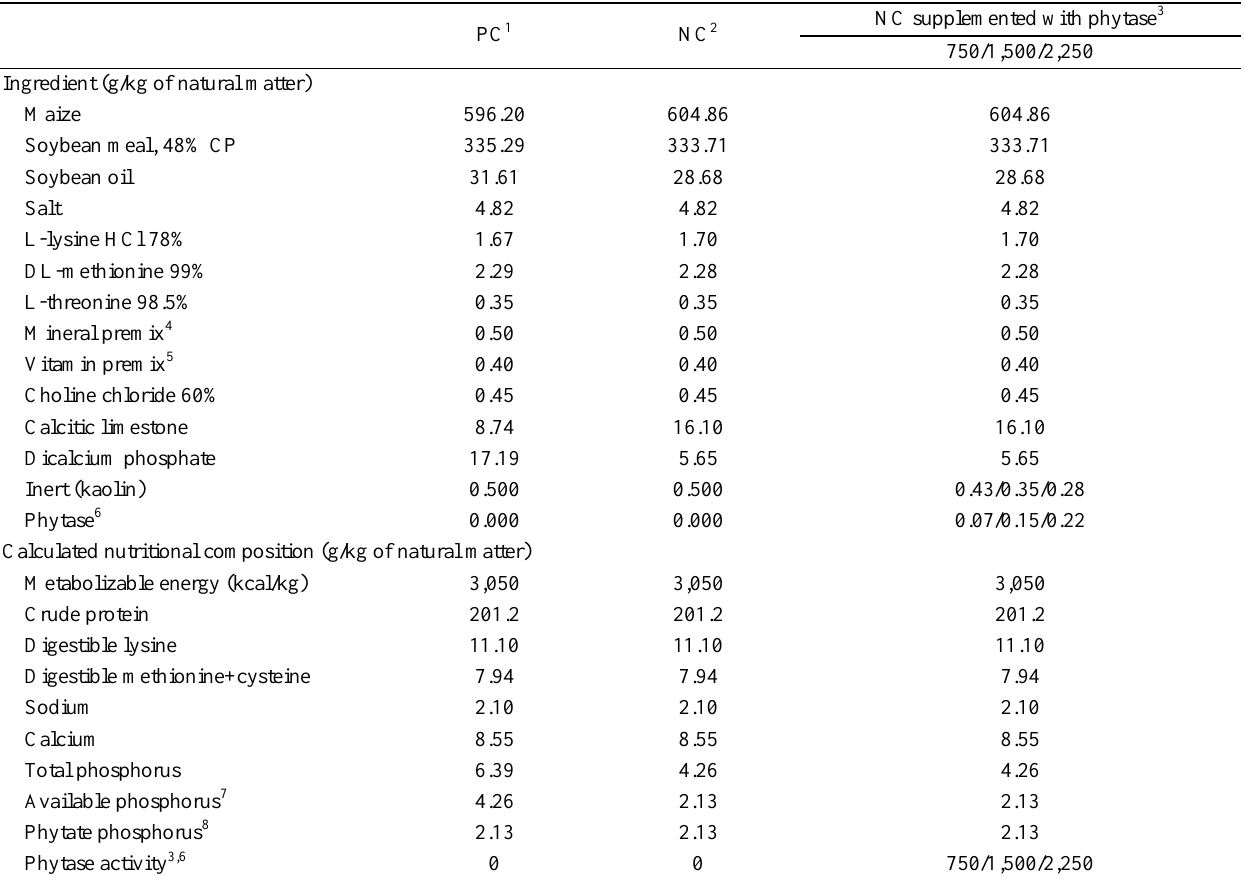
Table 1. Composition and nutritional contents of the experimental